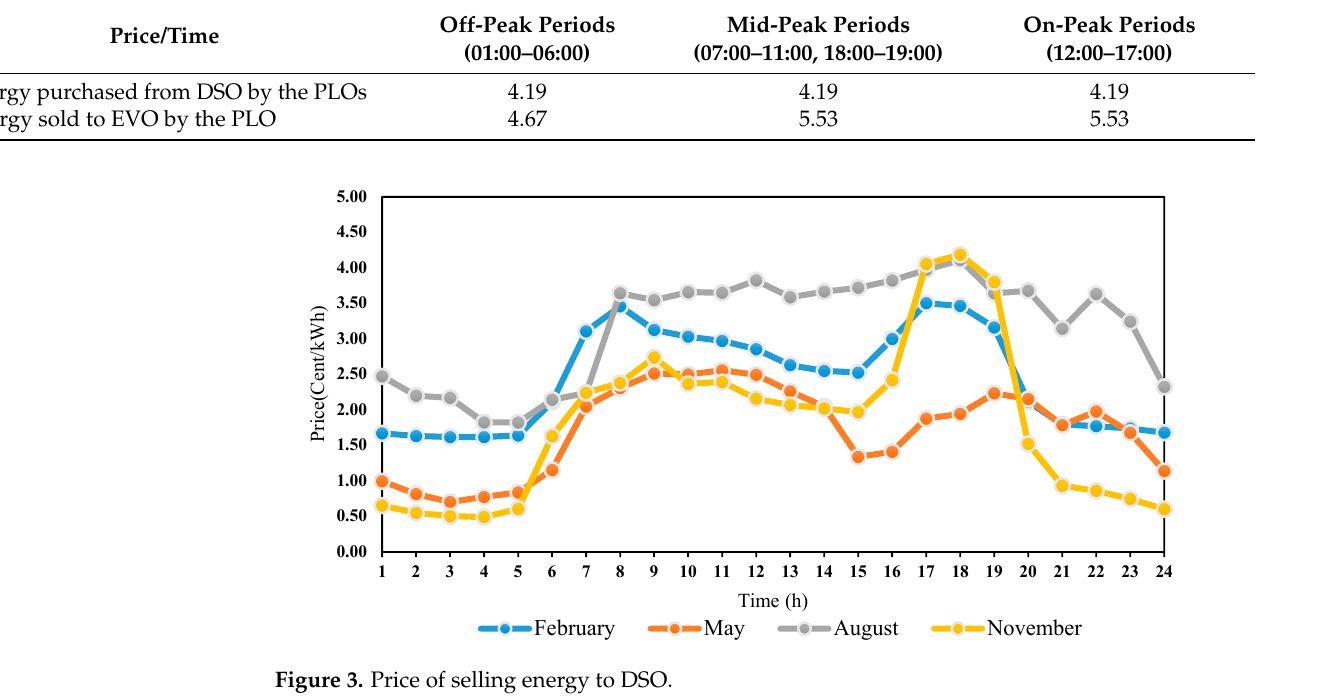
Figure 4. Required energy for charging EVs each month. The charging/discharging energy of all EVs in four months and the profit of the park- ing lot operator are presented in Table 5. According to Table 5, in August, the energy interaction between the parking lot operator and DSO is more than that in the other months which brings more profit to the parking lot operator.